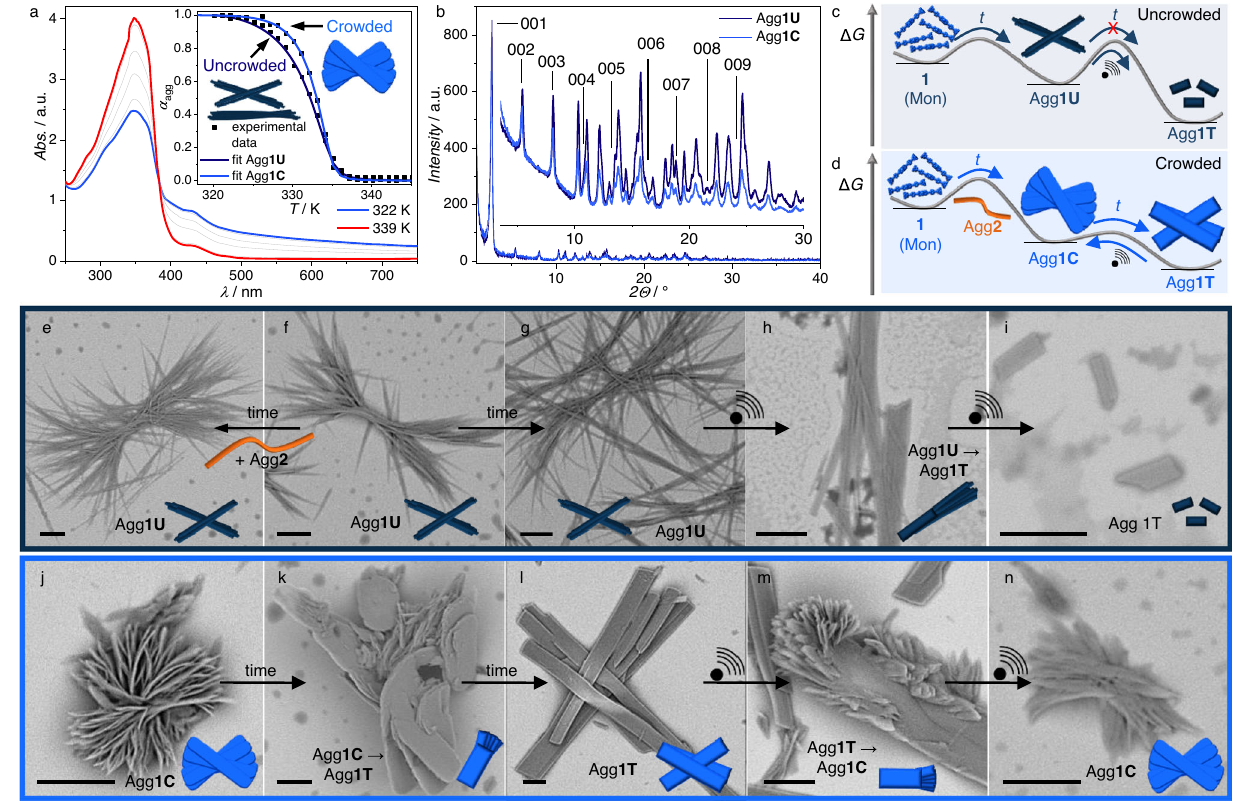
Fig. 3 | Self-assembly behaviour of Agg1C. a temperature-dependent UV/Vis spectra of 1 in crowded environments; inset: aggregation curves corresponding to the UV/Vis spectral changes in a with the corresponding aggregation curve in uncrowded environments for visual comparison. b XRD pattern of Agg 1C and Agg 1U . Qualitative energy landscape of the self-assembly of 1 in uncrowded ( c ) and